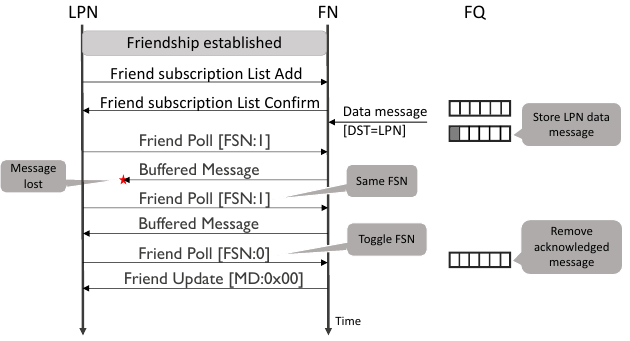
Figure 3. Network messages between the LPN and friend node